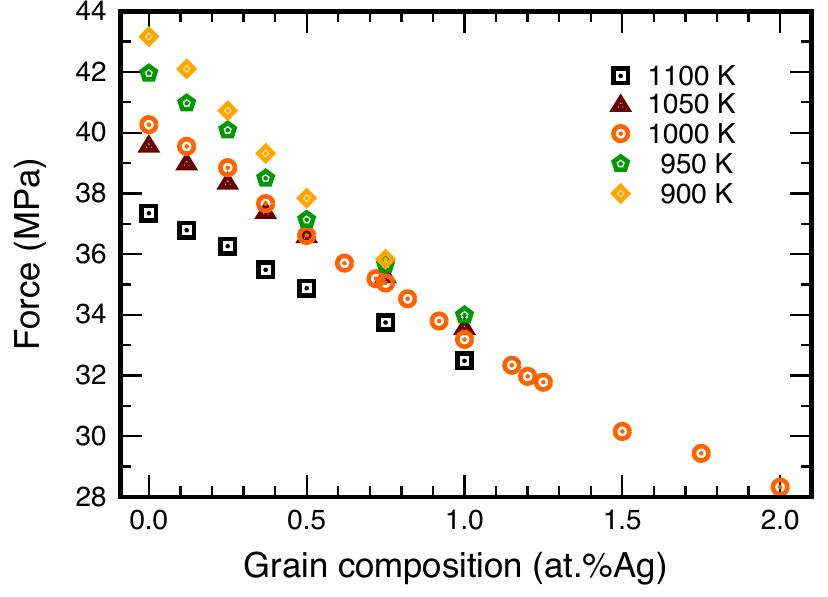
Figure 11. The capillary driving force for GB migration as a function of temperature and alloy